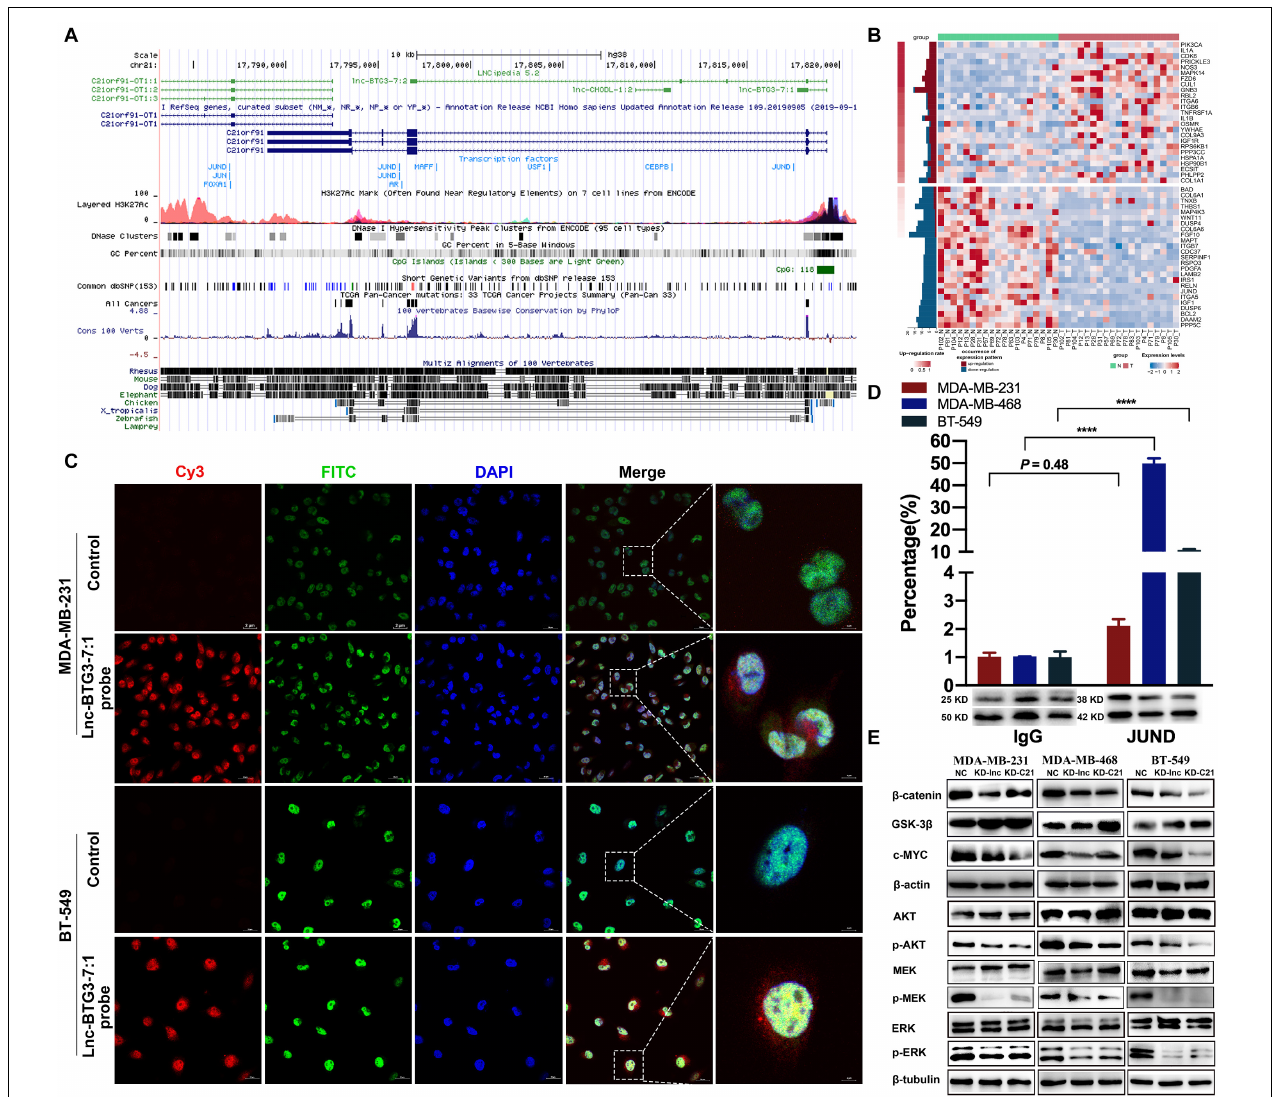
FIGURE 5 | Lnc-BTG3-7:1 and JUND co-regulate the transcription of C21ORF91 by activating AKT-GSK3 β - β -catenin and MAPK pathways in TNBC. (A,B) Bioinformatic analysis shown JUND and Lnc-BTG3-7:1 had high possibility of interaction. (C) RNA fluorescence in situ hybridization and immunofluorescence co-localization analysis. The probes of control and Lnc-BTG3-7:1 was visualized in TNBC cells MDA-MB-231 (upper panel) and BT549 (lower panel). (D) ChIP-qPCR. Lnc-BTG3-7:1 was enriched in JUND specific antibody immunoprecipitation group in MDA-MB-231 ( P = 0.48), MDA-MB-468 ( P < 0.05****) and BT-549 ( P < 0.05****) cells, respectively. (E) After knocking down Lnc-BTG3-7:1 or C21ORF91 gene, the expression of p -AKT, β -catenin and c-MYC proteins decreased and was along with GSK-3 β expression increased in GRB2-PI3K-AKT-GSK3 β - β -catenin pathway, at the same time, the expression of p -ERK and p -MEK in GRB2-RAS-RAF-MEK-ERK pathway